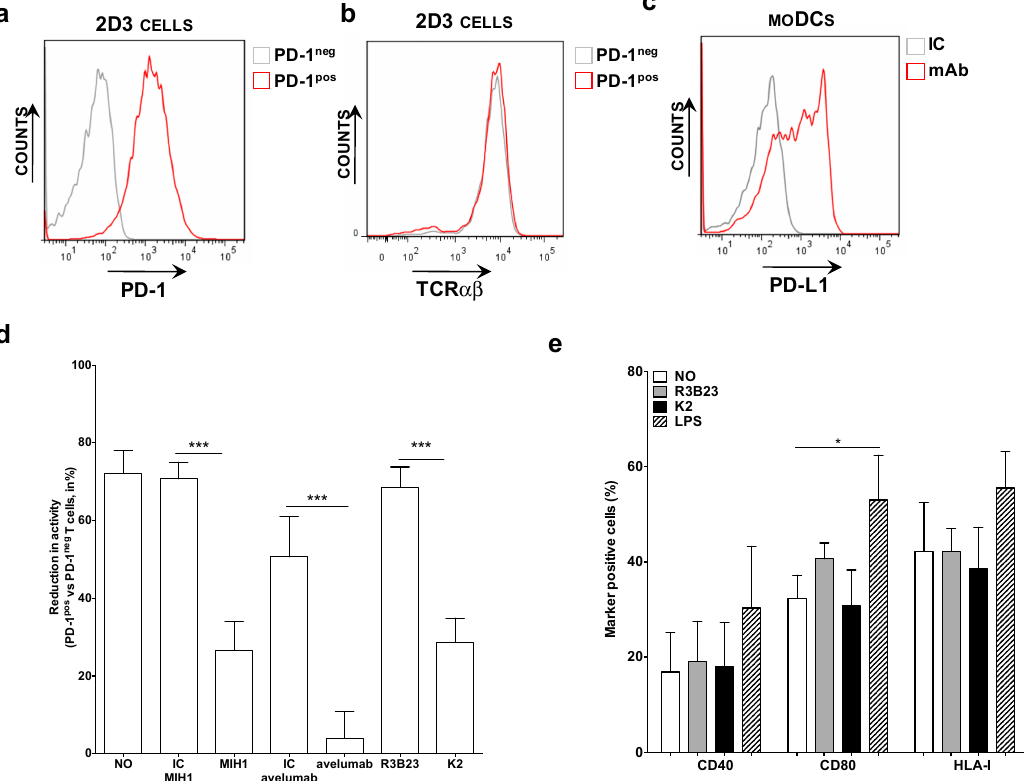
Figure 1. Antigen-specific activation of TCR pos PD-1 pos 2D3 cells by PD-L1 pos moDCs is enhanced in the presence of blocking anti-PD-L1 mAbs or sdAb K2. ( a ) Histogram showing PD-1 neg [grey] and PD-1 pos [red] 2D3 cells stained with anti-PD-1 mAbs. These are representative for 6 independent experiments. ( b ) Histogram showing the expression of the TCR recognizing gp100 in the context of HLA-A2 on PD-1 neg [grey] and PD-1 pos [red] 2D3 cells stained with anti-TCR mAbs. These are